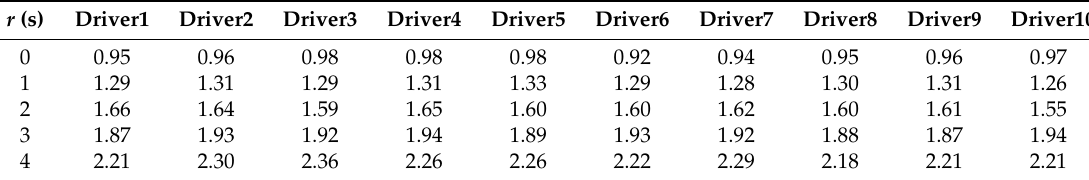
Table 13. Testing time (s) of O2.